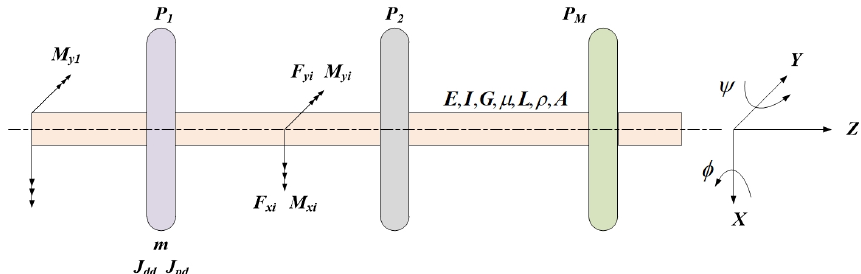
Figure 1. Finite element rotor